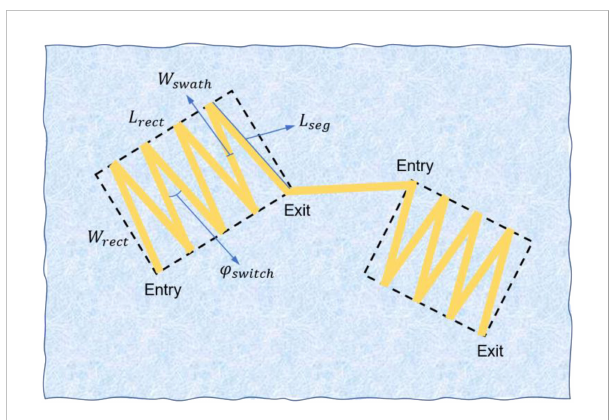
FIGURE 3 AUV trajectory for intensive mapping in the minimum area bounding rectangles (Top